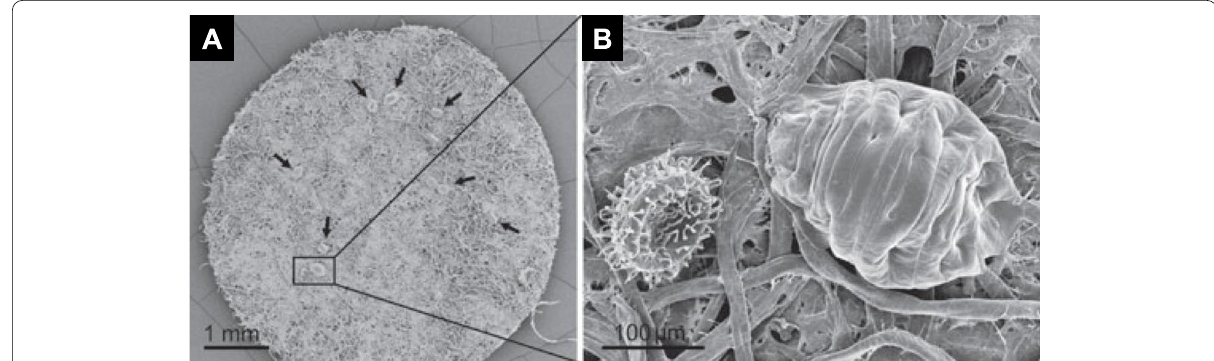
Fig. 4 Scanning electron micrographs of the tardigrade Richtersius coronifer . A Overview showing tardigrades (arrows) on a filter paper. B Magnified view of a rectangle in (A) showing an egg (left) and a tardigrade (right) (Persson et al. 2011 with permission from the